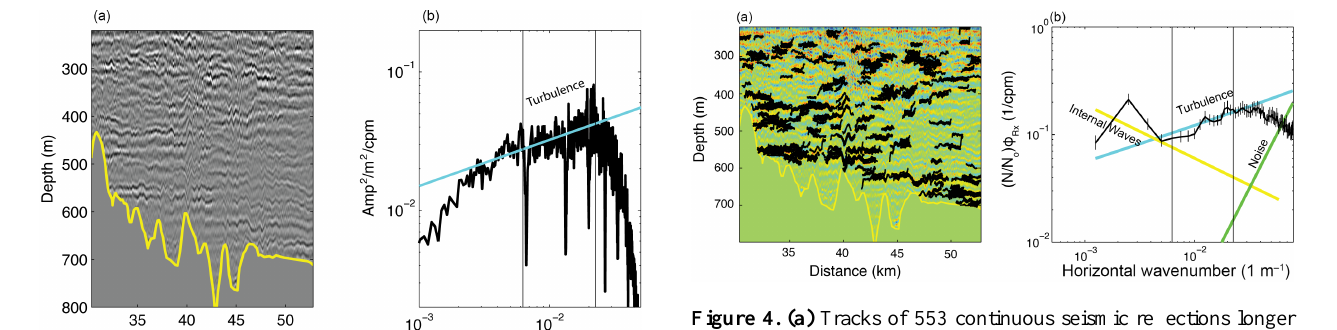
Figure 4. (a) Tracks of 553 continuous seismic reflections longer than 800 meters are shown in black over seismic line Limon1. (b) Displacement slope spectra with 95% bootstrap confidence in- tervals of the tracked seismic reflections show line Limon1 to be dominated by the characteristic slope of turbulence, shown in cyan, over the horizontal wavenumber range (0.00625–0.0225)cpm, or (44–160)m horizontal wavelengths. Average turbulent diffusivity calculated for Limon1 over this image is 1.54 × 10 − 4 m 2 s − 1 . The turbulence subrange of this data set is emphasized herein by gray vertical lines marking the upper and lower wavenumber limits. Characteristic slopes of internal waves (GM77) and noise (KM07b) are shown in yellow and